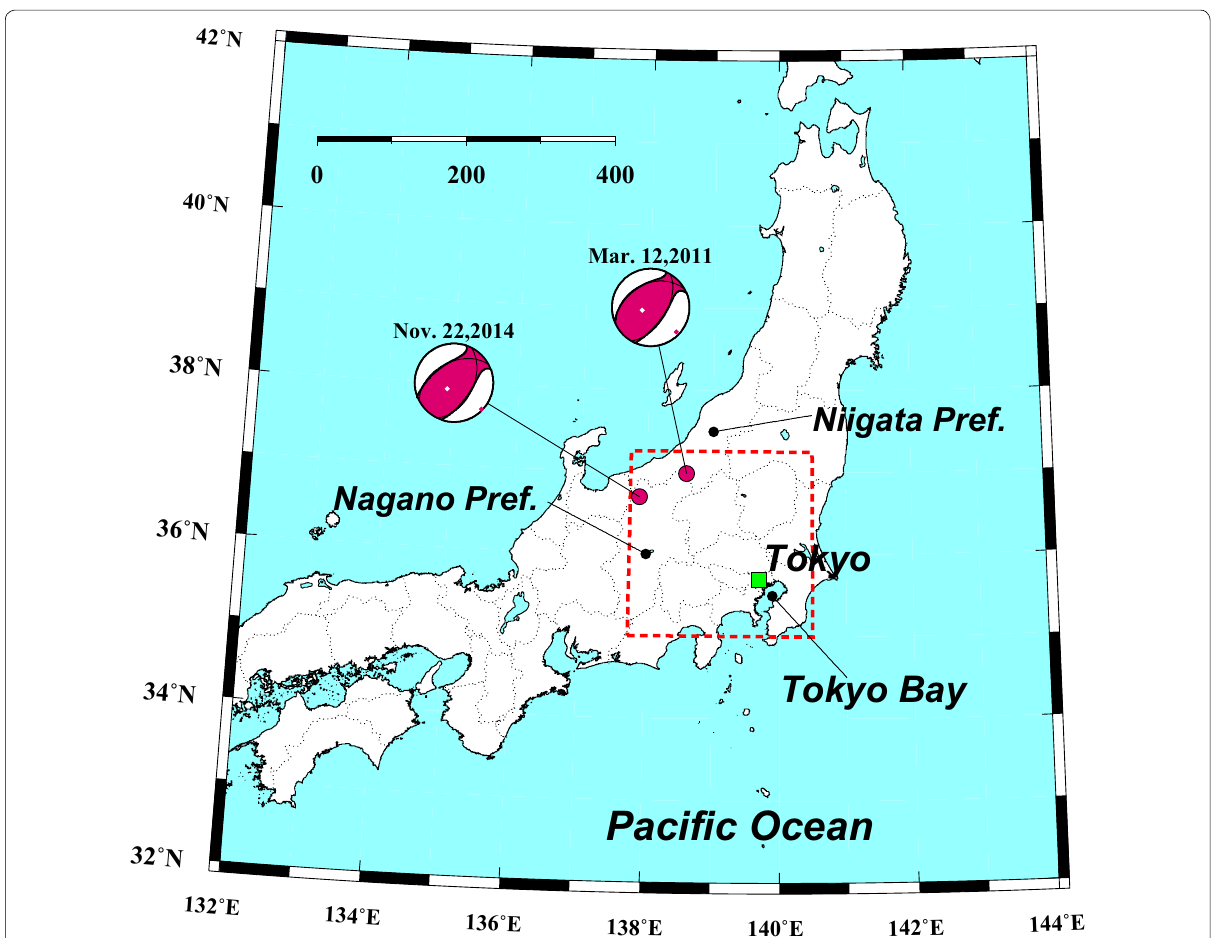
Fig. 1 Epicenters of the events used in this study. The area in the red square is enlarged in Fig. 2. Dashed lines show the prefectural borders in Japan. The event source mechanisms are the moment tensor solutions from F-net (Okada et al. 2004)